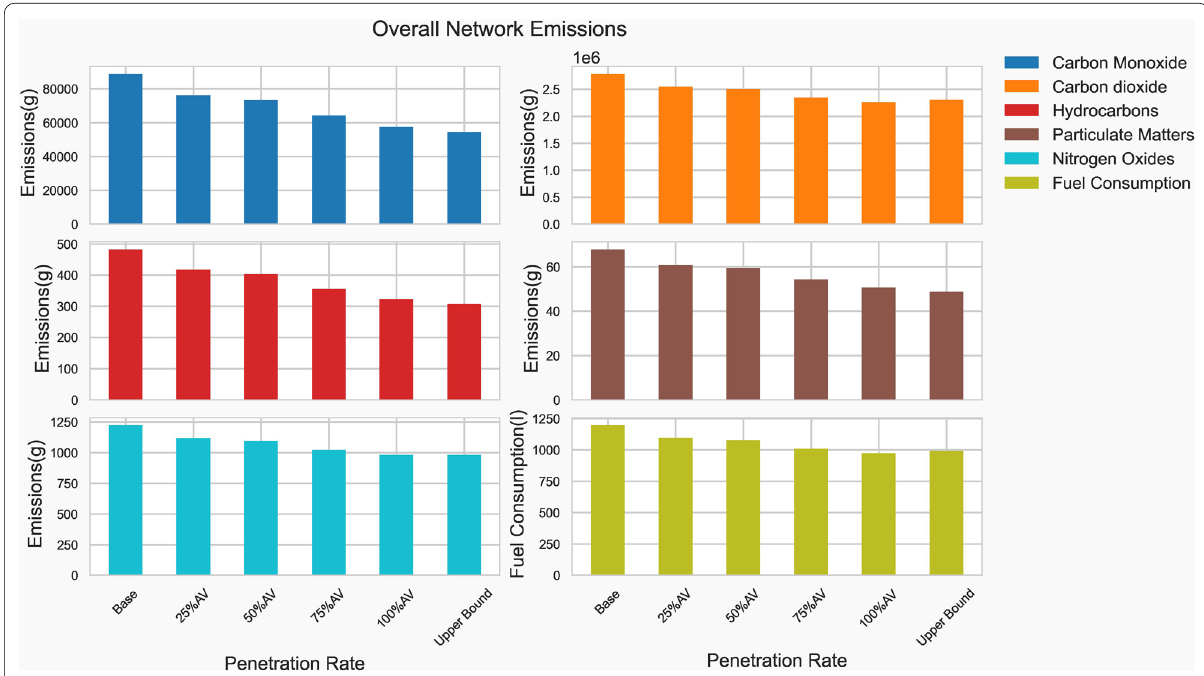
Fig. 9 Overall emissions from the network (Source: